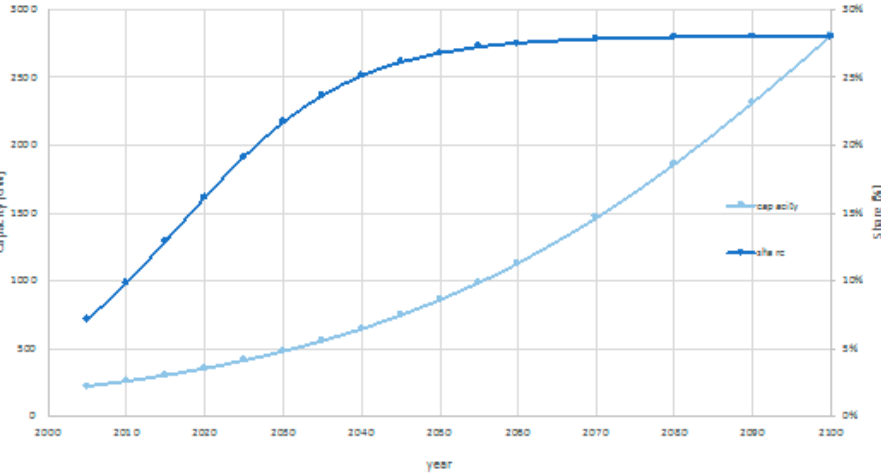
Figure 7. Europe wind technology capacity development based on the reference scenario of REMIND until the year 2100 (own work).